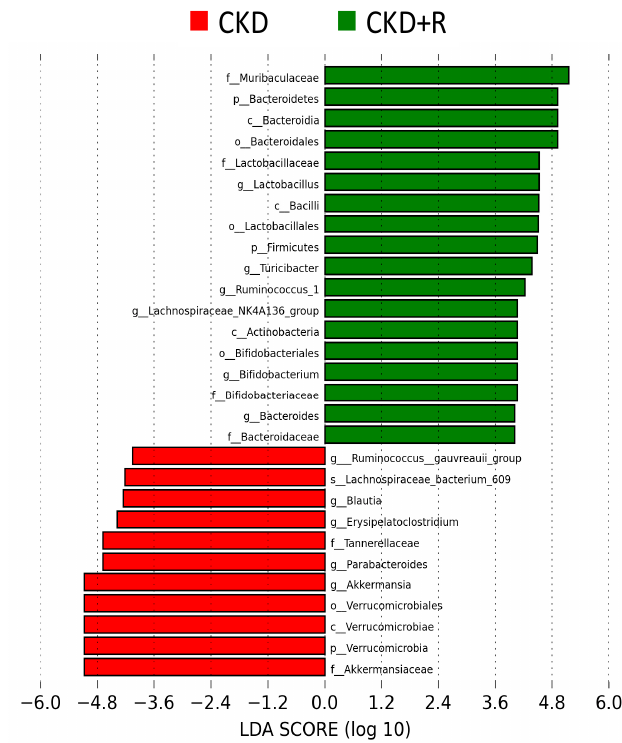
Figure 5. Linear discriminant analysis effect size (LEfSe) was applied to identify enriched bacterial species. The threshold of the linear discriminant was set to 4. Different taxonomic levels of bacteria are given, reaching from phylum (p) and class (c) via order (o) and family (f) down to genus (g) and species (s). The most enriched and depleted bacterial taxa in (A) the CKD (red) versus the C group (green) and (B) the CKD (red) versus the CKD+R group (green) are shown.